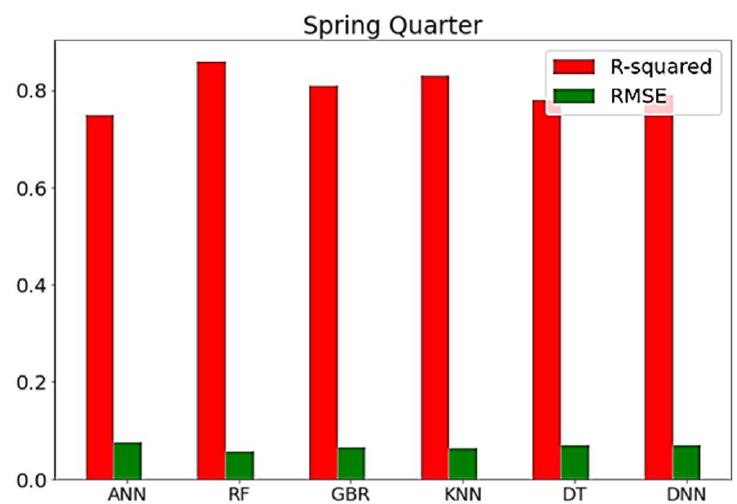
Figure 6. R 2 and RMSE metrics for the ML algorithms autumn data set.